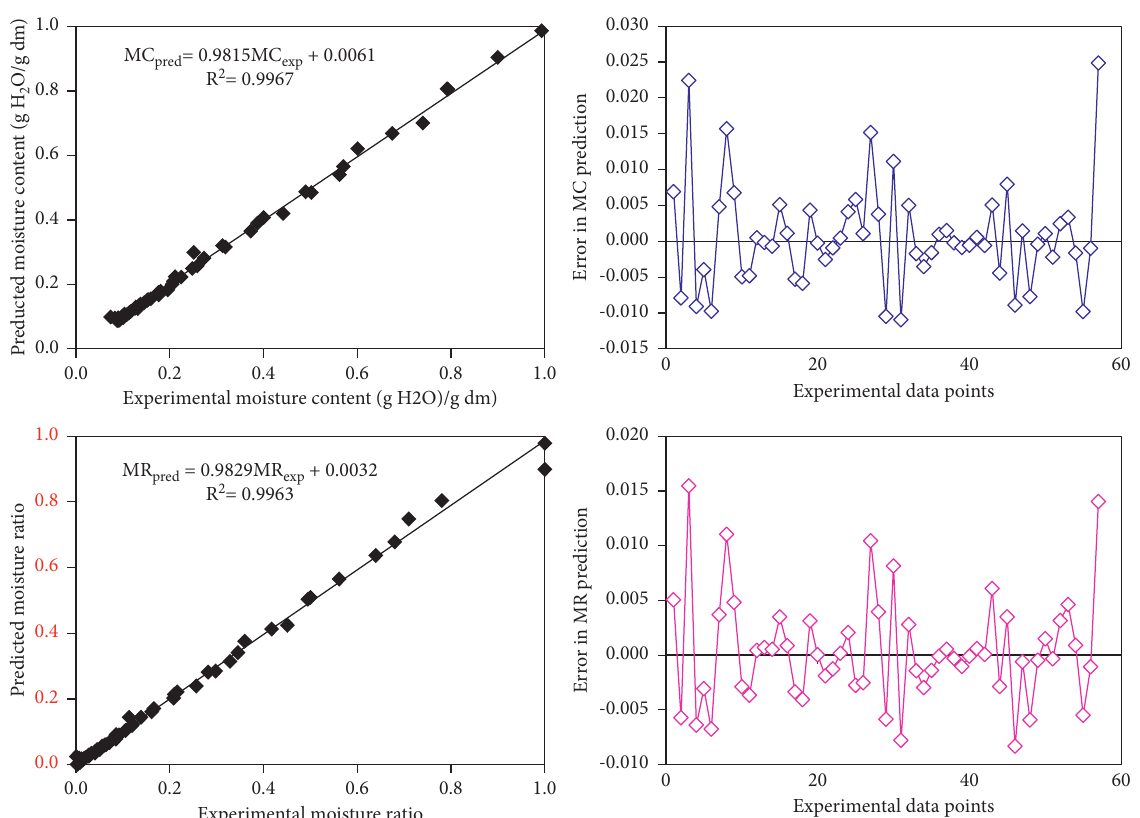
Figure 5: Simulated performance of the generated neural network along with error variation graph showing ANN learning (random error indicates proper training).